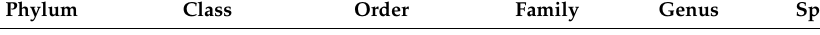
Table 3. List of lichen from the National Park of Urmia Lake (localities: Rahmanloo and Saraydeh) [8]. Phylum Class Order Family Genus Species